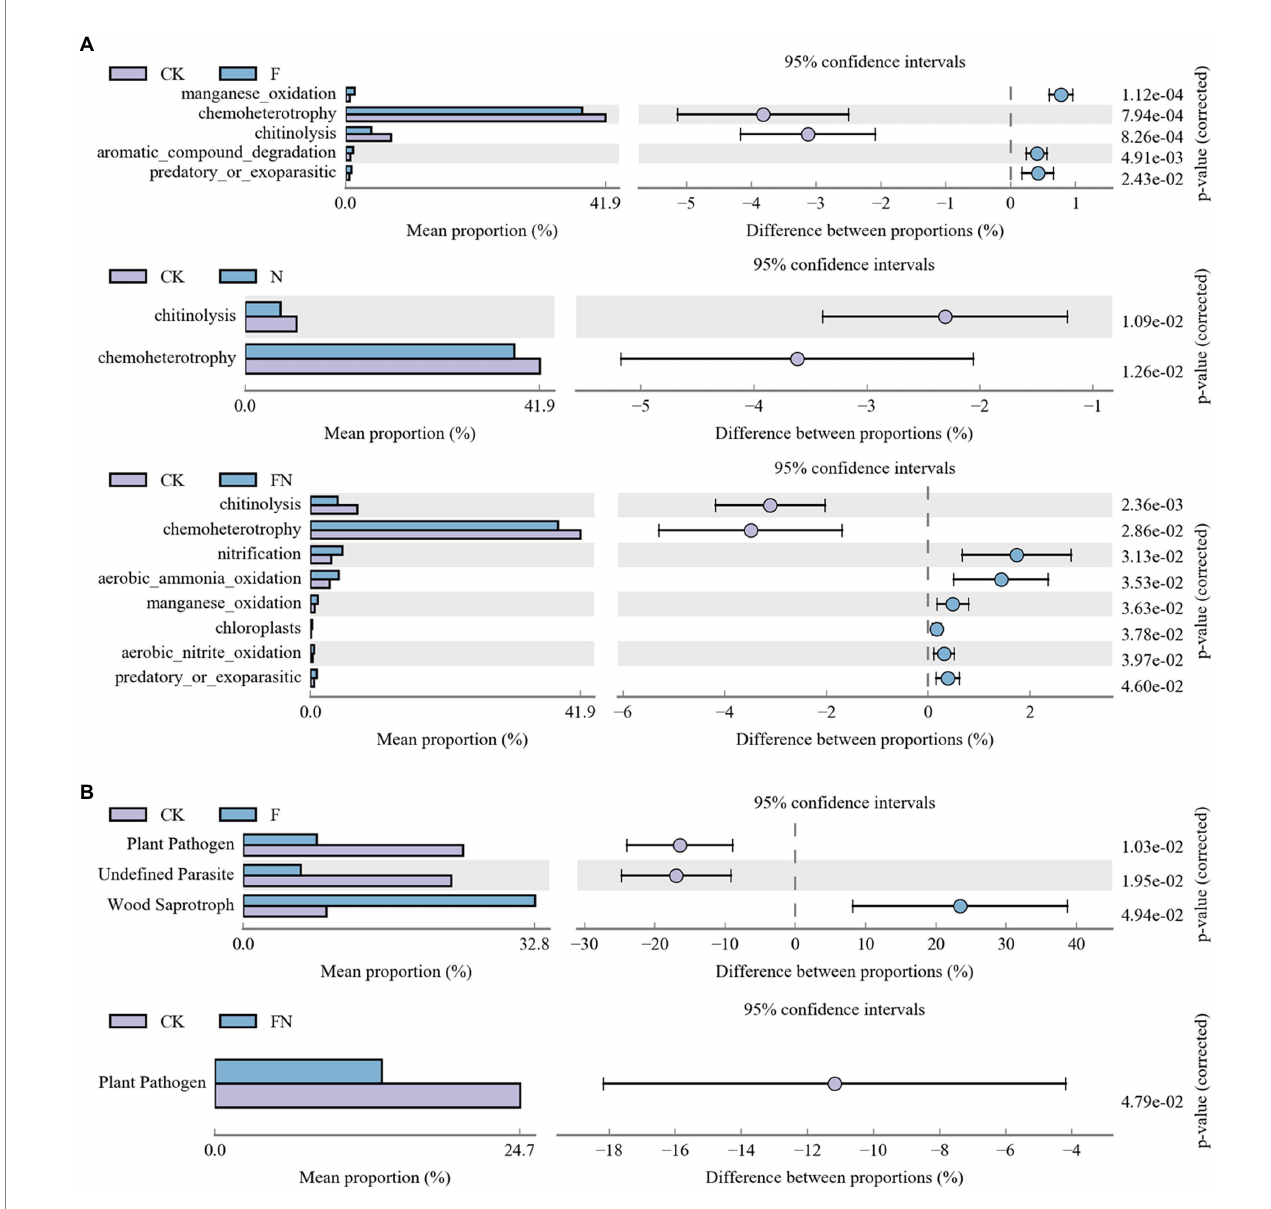
FIGURE 6 Bacterial (A) and fungal (B) functions affected by different treatments. CK, non-inoculated; F, inoculated with B. velezensis FH-1; N, inoculated with B. diminuta NYM-3; FN, inoculated with B. velezensis FH-1 and B. diminuta